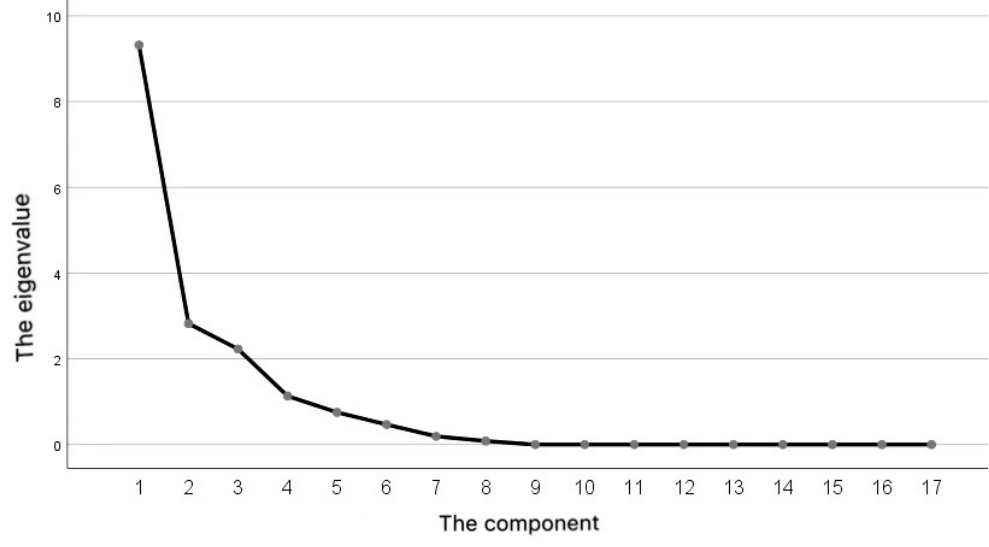
Figure 1. Crushed stone.